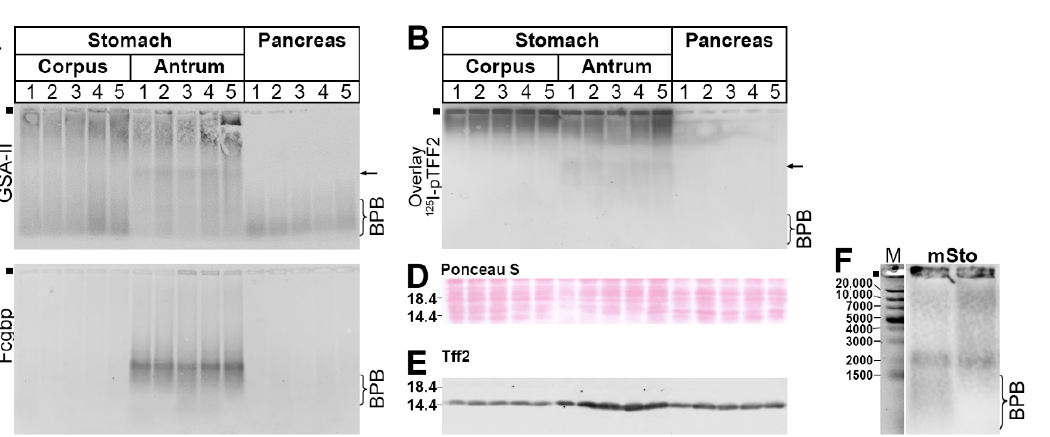
Figure 8. RT-PCR analysis. Muc2 , Tff2 , Muc6 , A4gnt , Dmbt1 , and Epdr1 expression in the proximal, medial, and distal portions of the murine duodenum. The number of amplification cycles is given in parentheses. As controls, the expression of Actb and Rps26 , respectively, was monitored.